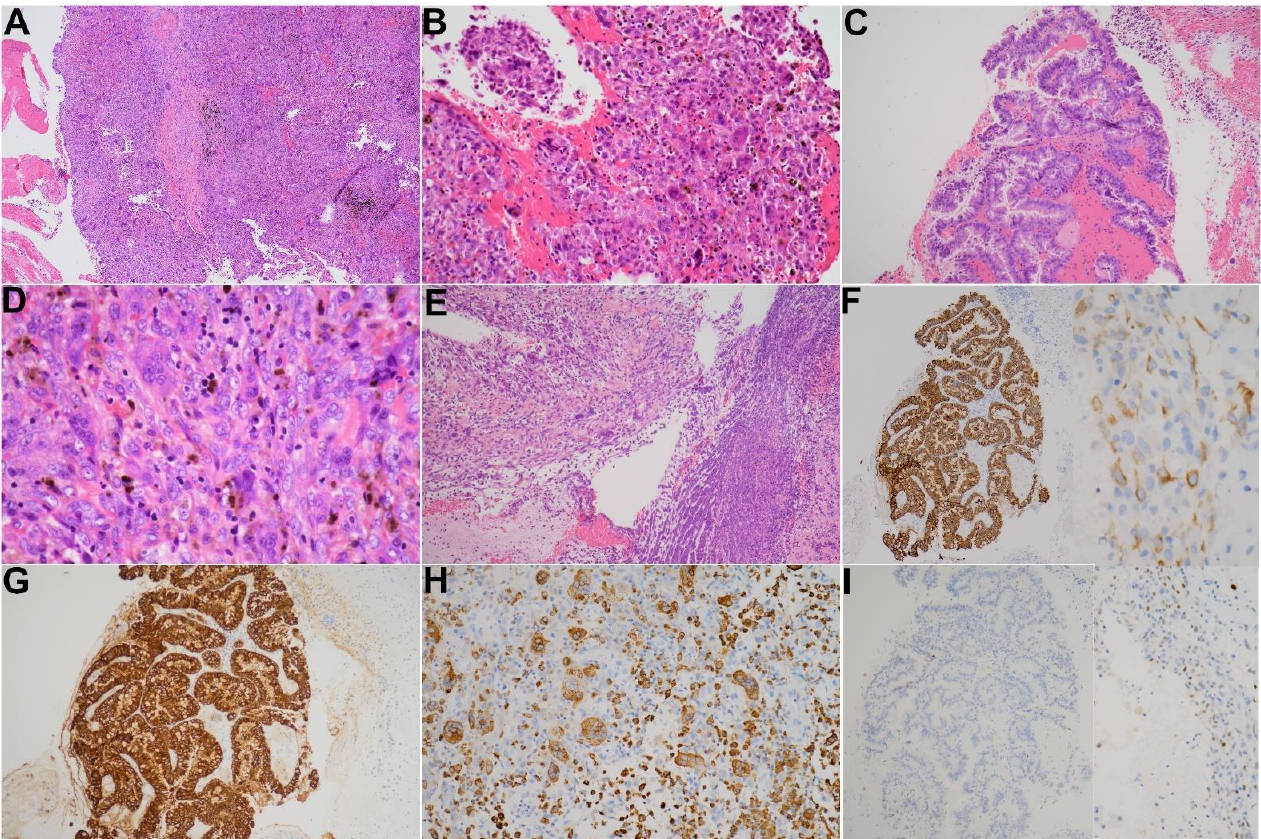
Figure 4. Pathological features of this case. ( A ) Hypercellular tumor in a background of hemorrhage and numerous hemosiderin pigments (H&E stain, × 40). ( B , D ) The tumor is composed of three cell types including OGCs, mononuclear histiocytes and neoplastic mononuclear cells (H&E stain, × 100 and × 400, respectively). ( C ) Malignant epithelia exhibiting papillary and tubular glandular structure (H&E stain, × 100). ( E ) Foci of tissue necrosis and inflammatory exudates (H&E stain, × 100). ( F ) Immunohistochemistry of AE1/AE3 highlights the malignant epithelia and mononuclear neoplastic cells ( × 100). ( G ) Immunohistochemistry of CK19 highlights the malignant epithelia ( × 100). ( H ) Immunohistochemistry of CD68 highlights the osteoclast-like giant cells and